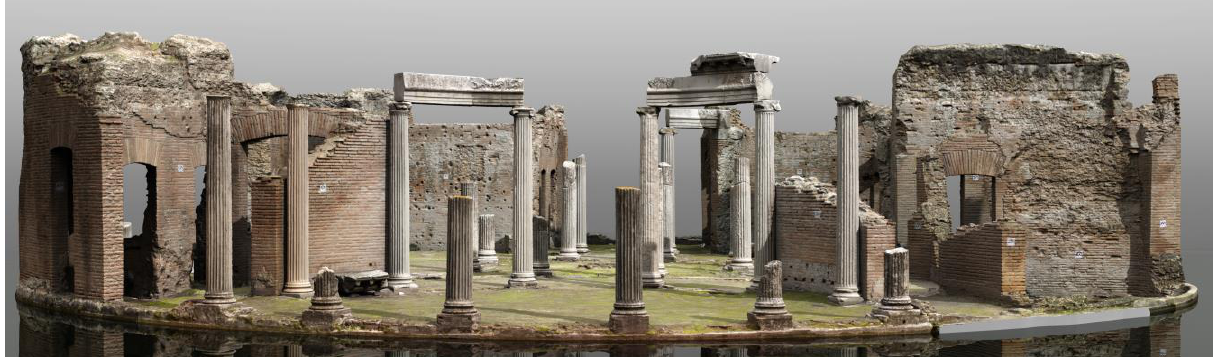
Figure 16. The Maritime theatre digital model obtained through the pipeline exposed in the paper. It can be efficiently used as the base for virtual anastylosis and other studies. Every part of the model is a CSG and allows sections as well as the production of reliable high resolution ortho-image.